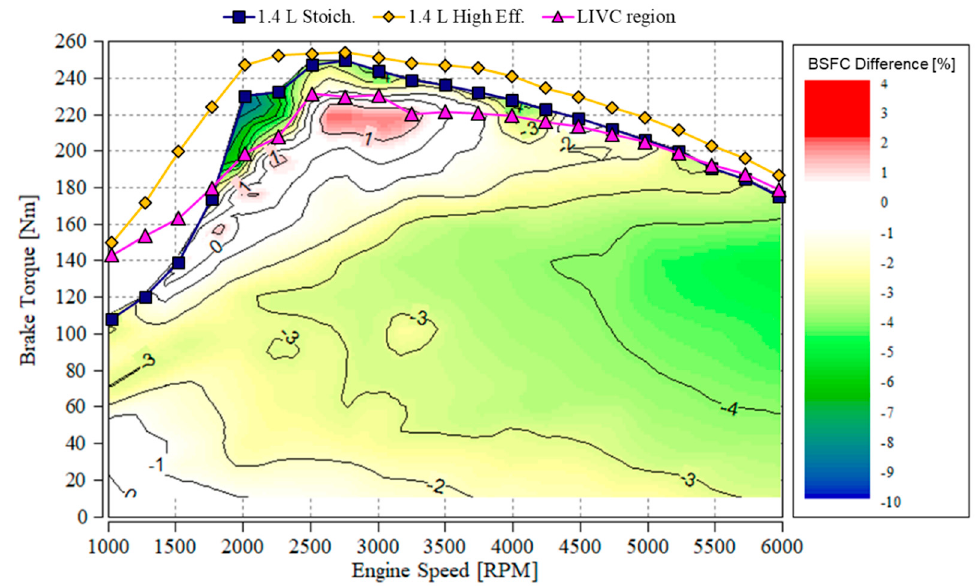
Figure 6. Percentage difference of BSFC between the 1.4L High Eff. Engine and the 1.4L Stoich. Engine.